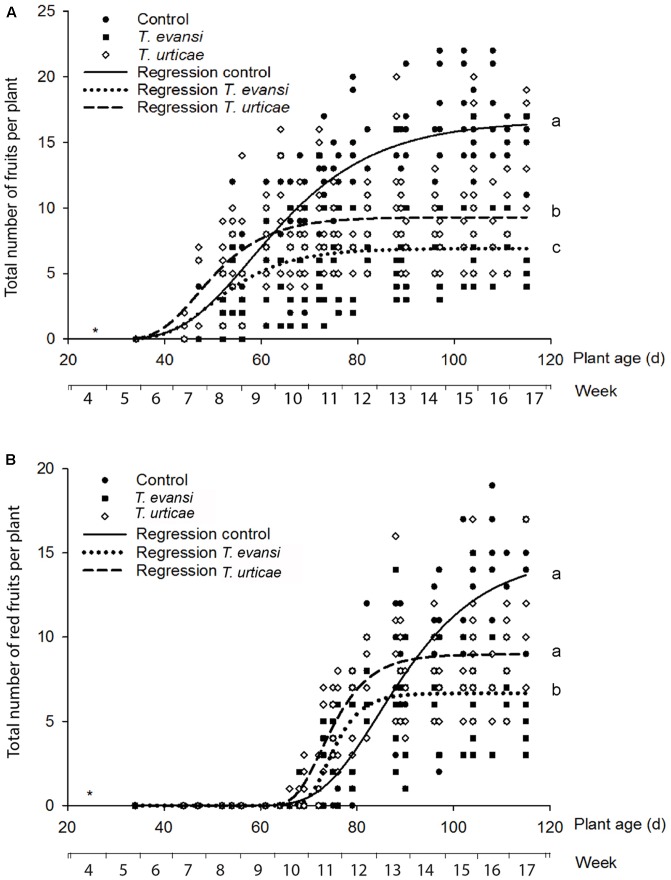
Total fruits (A) and red fruits (B) production per plant of spider mites infested Micro-Tom plants in time series post-infestation. The data were fitted to the regression equation: f = a∗(1-exp(-b∗x))ˆc. The solid line shows the average total number of fruits for uninfested control plants (closed circles) (A: R2 = 0.79, P < 0.0001; B: R2 = 0.86, P < 0.0001). The dotted line shows the average total number of fruits for the T. evansi infested plants (closed rectangles) (A: R2 = 0.39, P < 0.0001; B: R2 = 0.67, P < 0.0001). The dashed line shows the average total number of fruits for T. urticae infested plants (open circles) (A: R2 = 0.45, P < 0.0001; B: R2 = 0.75, P < 0.0001). Differences in mean fruit production per plant among treatments over time were tested by means of a linear mixed effects (LME) model using the number of fruits and plant as a random factor. Different letters next to the curves indicated overall significant differences among treatments (lsmeans of R, P < 0.05). Asterisk (∗) indicated the age of plants when infested with mites.